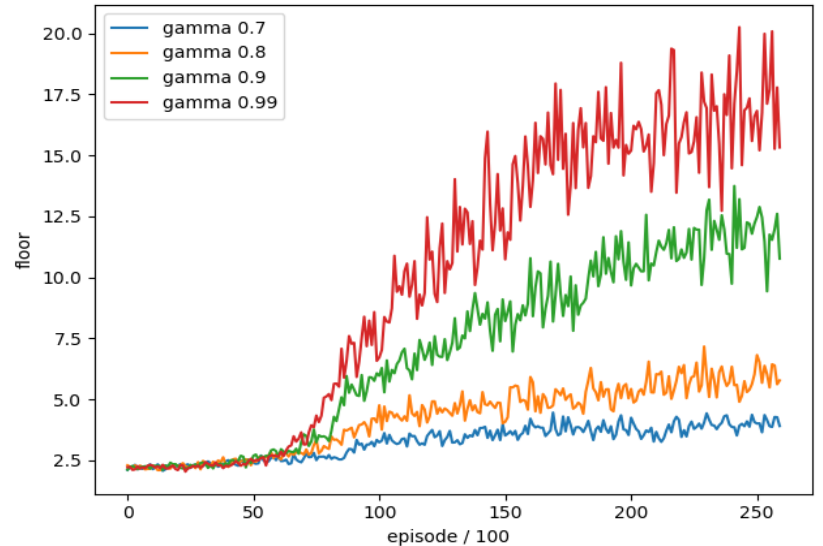
Figure 16. The training trend of discount value.